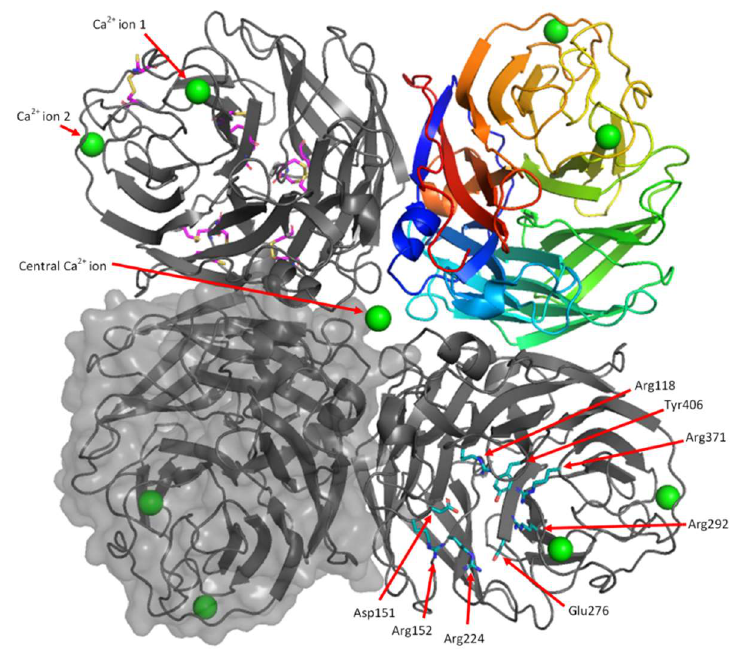
( b ) Figure 6. Overall structural comparison with other NA structures. ( a ) Structural alignment of NA monomers from various influenza virus strains and expression systems. Lime green: HEK NA, A/BrevigMission/1/1918 (H1N1). Cyan: 3BEQ, A/BrevigMission/1/1918 (H1N1). Light pink: 3SAL, A/duck/Alberta/60/1976 (H12N5). Grey: 1F8E, A/tern/Aus- tralia/G70C/1975 (H11N9). Purple: 4K1K, A/RI/5+/1957 (H2N2). Orange: 3TI4, A/California/04/2009 (H1N1). Dark Green: 2HTY, A/Vietnam/1203/04 (H5N1). Teal: 3NSS, A/California/04/2009 (H1N1). Hot pink: 4KS1, A/duck/Ukraine/1/1963 (H3N8). Chain A from each structure was chosen for the alignment. This superposition was performed in PyMOL, using